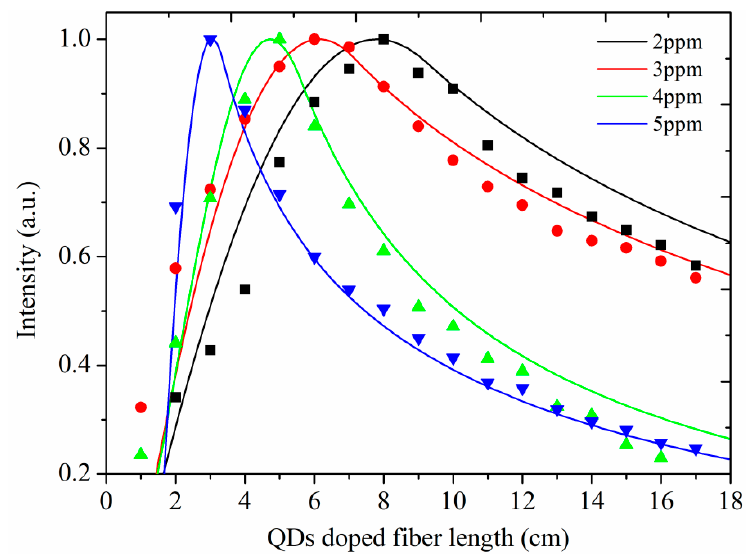
Figure 7. Output SE intensity of four kinds of POFs as a function of doped fiber length (the solid lines were the simulation results, and the dots were the experimental results).